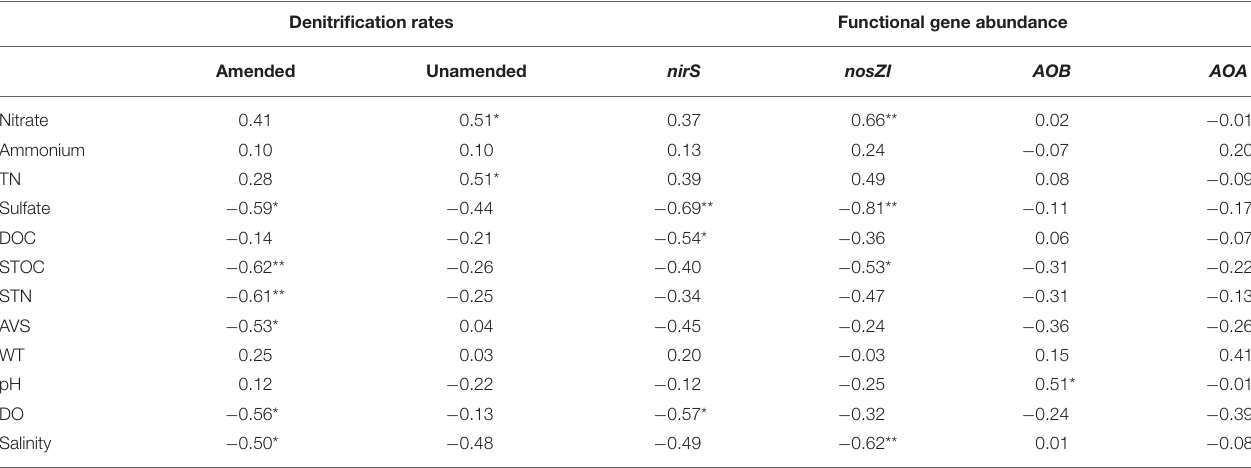
TABLE 1 | Pearson’s correlation analysis between denitrification rates (amended and unamended) and environmental variables ( n = 17) and between functional gene abundance (nirS, nosZI , AOB , and AOA ) and environmental variables ( n =